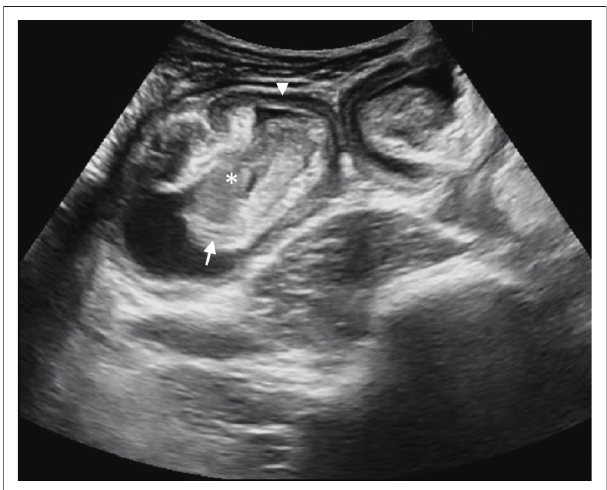
Source : Ultrasound Department, Grey’s Hospital Radiology, Pietermaritzburg (obtained from actual patient) FIGURE 1: Axial ultrasound of the abdomen depicting a bowel-within-bowel appearance with concentric thickening of the bowel (arrowhead), with the mesentery of the intussusceptum (arrow) dragged into the intussuscipiens (asterisk).